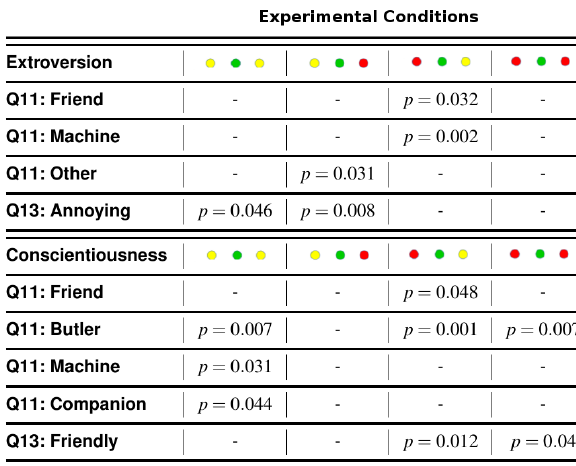
Figure 6: Multiple linear regression analysis to predict personalities characteristics of the participants from their perception of the robot Jace and the experimental conditions they were tested